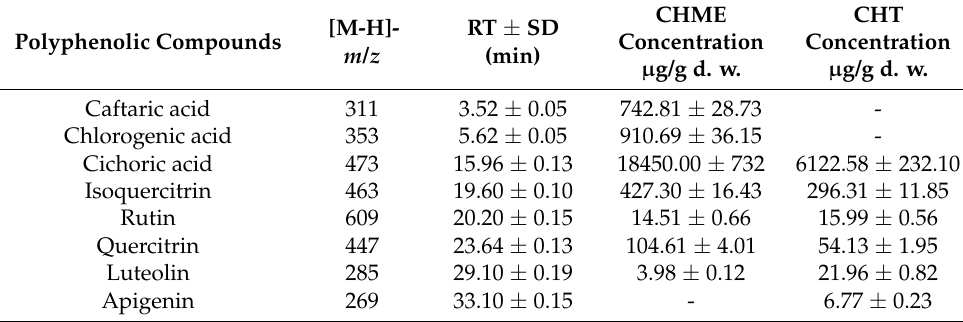
CHT CHME [M-H]- RT ± SD Concentration Concentration m/z (min) µ g/g d. w. µ g/g d. w.